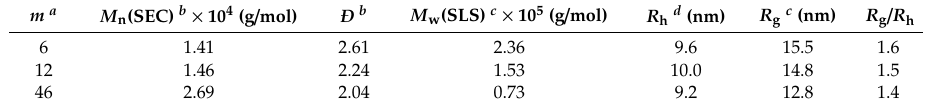
Figure 3. 1 H NMR spectra for ( a ) PMEA, ( b ) P(MEA / MPC 6 ), ( c ) P(MEA / MPC 12 ), and ( d ) P(MEA / MPC 46 ) in methanol- d 4 at room temperature. Table 1. Characteristics of the P(MEA / MPC m )